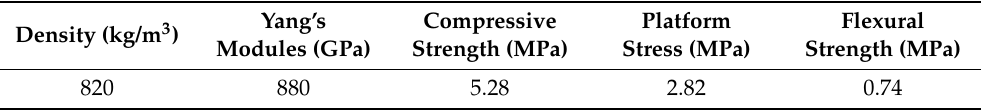
Table 1. Main physical and mechanical parameters of foamed